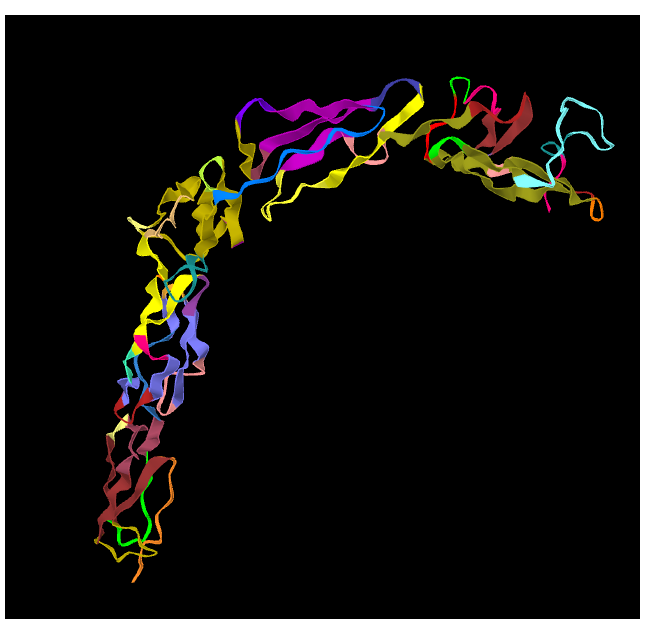
Figure 2. A picture of the secondary structure of the apolipoprotein-H obtained with the software